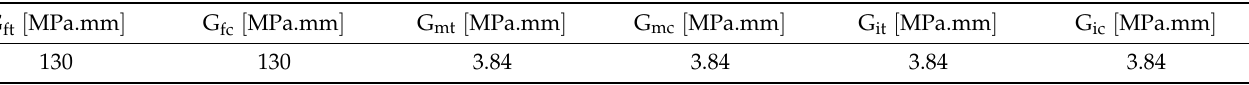
Table 4. Fracture energy for the pultruded GFRP material used in the three-point bending beam. G ft [ MPa.mm ]